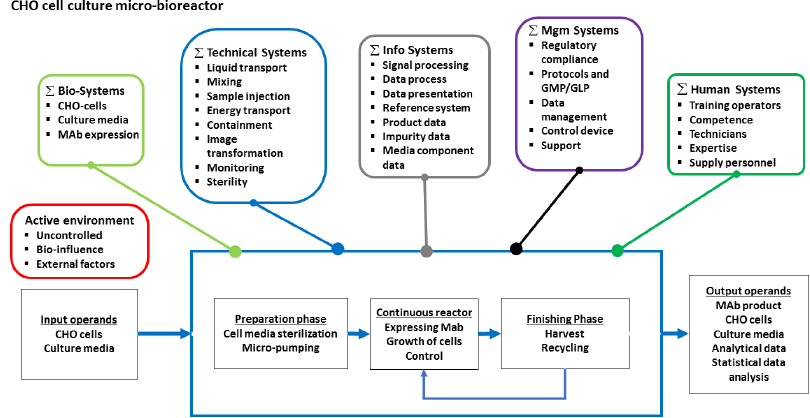
Figure 5. Hubka-Eder map showing the functional systems and subsystems in a continuous recycled MBR for bioprocess optimization of a CHO cell culture producing monoclonal antibody.